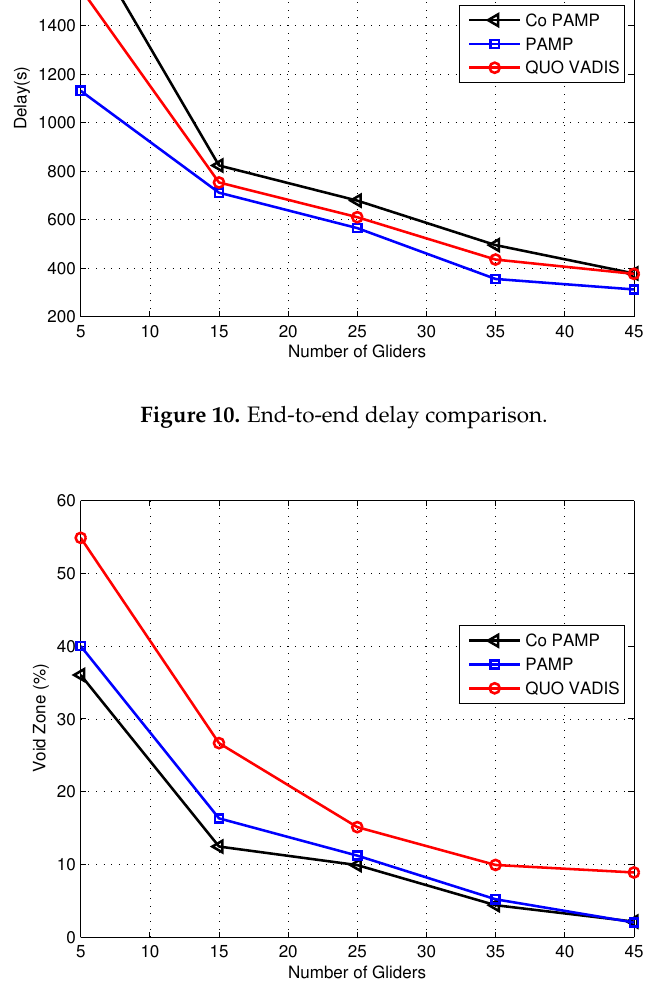
Figure 11. Void zone